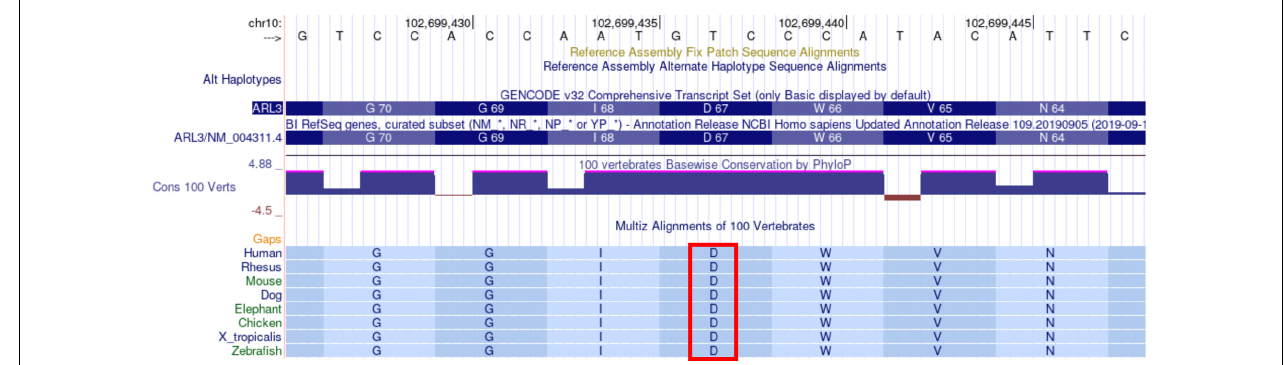
FIGURE 6 | Alignment of ARL3 amino acids surrounding the location corresponding to the D67V mutation in sequences from multiple species. The Asp (D) at residue 67 is indicated by the red rectangle and is conserved across all of the species shown, including human, rhesus, mouse, dog, elephant, chicken, X_tropicalis, and zebrafish. The sequences were aligned with use of the UCSC genome browser.